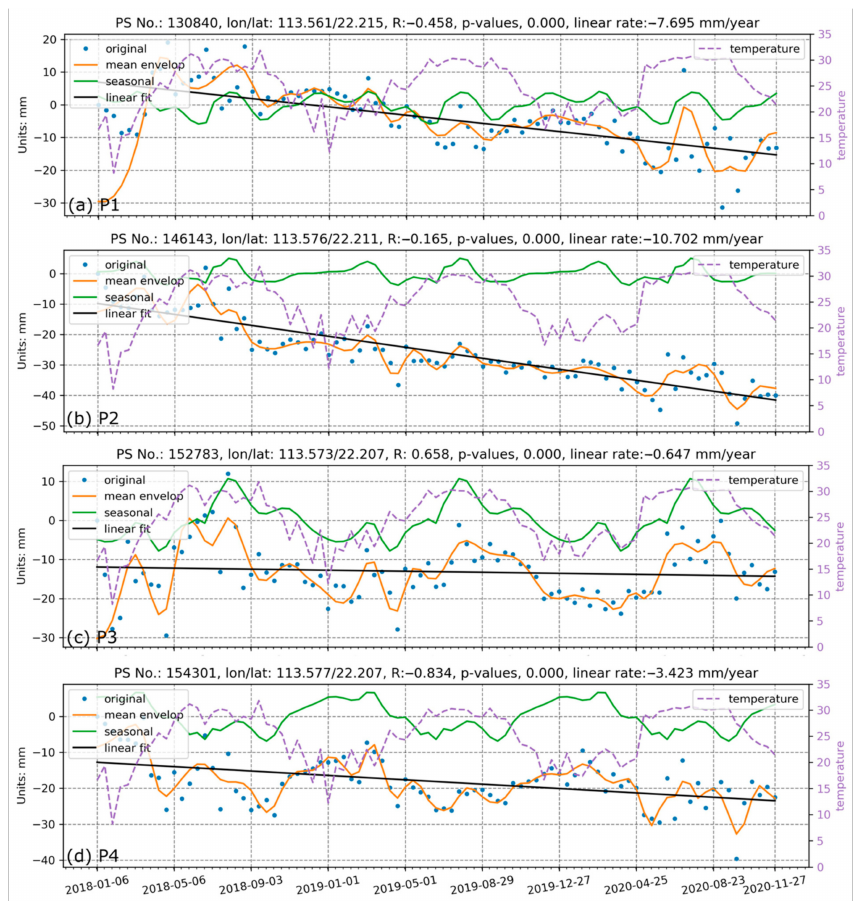
Figure 10. Time-series processing results of ( a ) P1 located on the bridge connecting Zhuhai city and Zhuhai Passenger Terminal, ( b ) P2 located on the northern cloister, ( c , d ) P3 and P4 located at the front and back of Zhuhai Passenger Terminal.